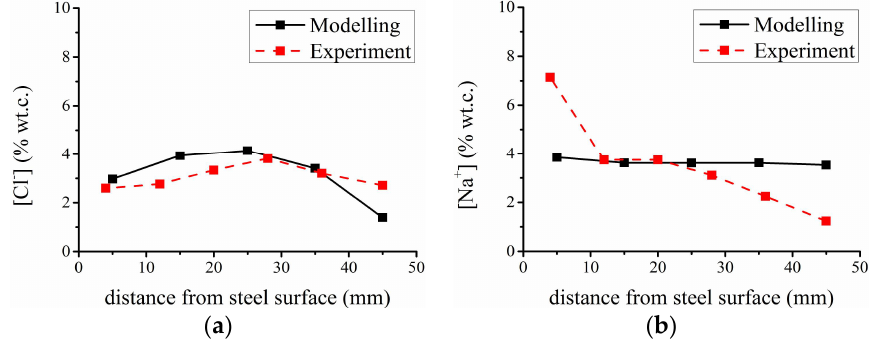
Figure 8. Comparison of the concentration profiles between modelling and the experimental test after the electrochemical treatment of 90 days ( a ) Cl − ; ( b ) Na +.